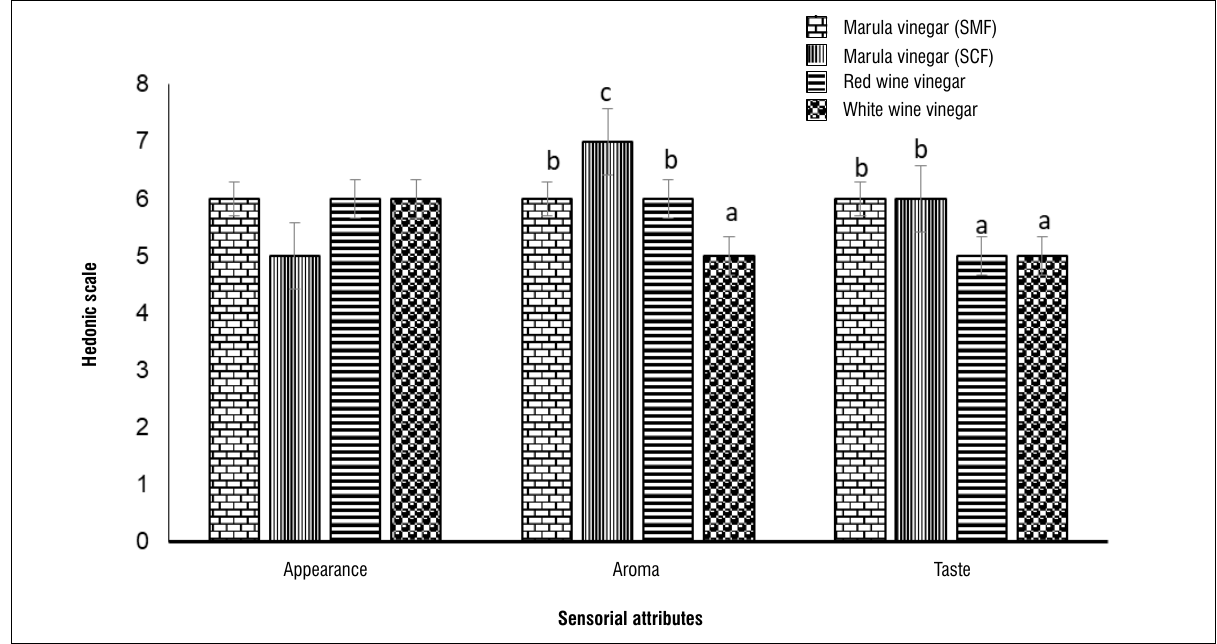
figure 3: Sensory evaluation of marula and red and white grape vinegars using the hedonic scale. Bars with the same superscript were not significantly different ( p